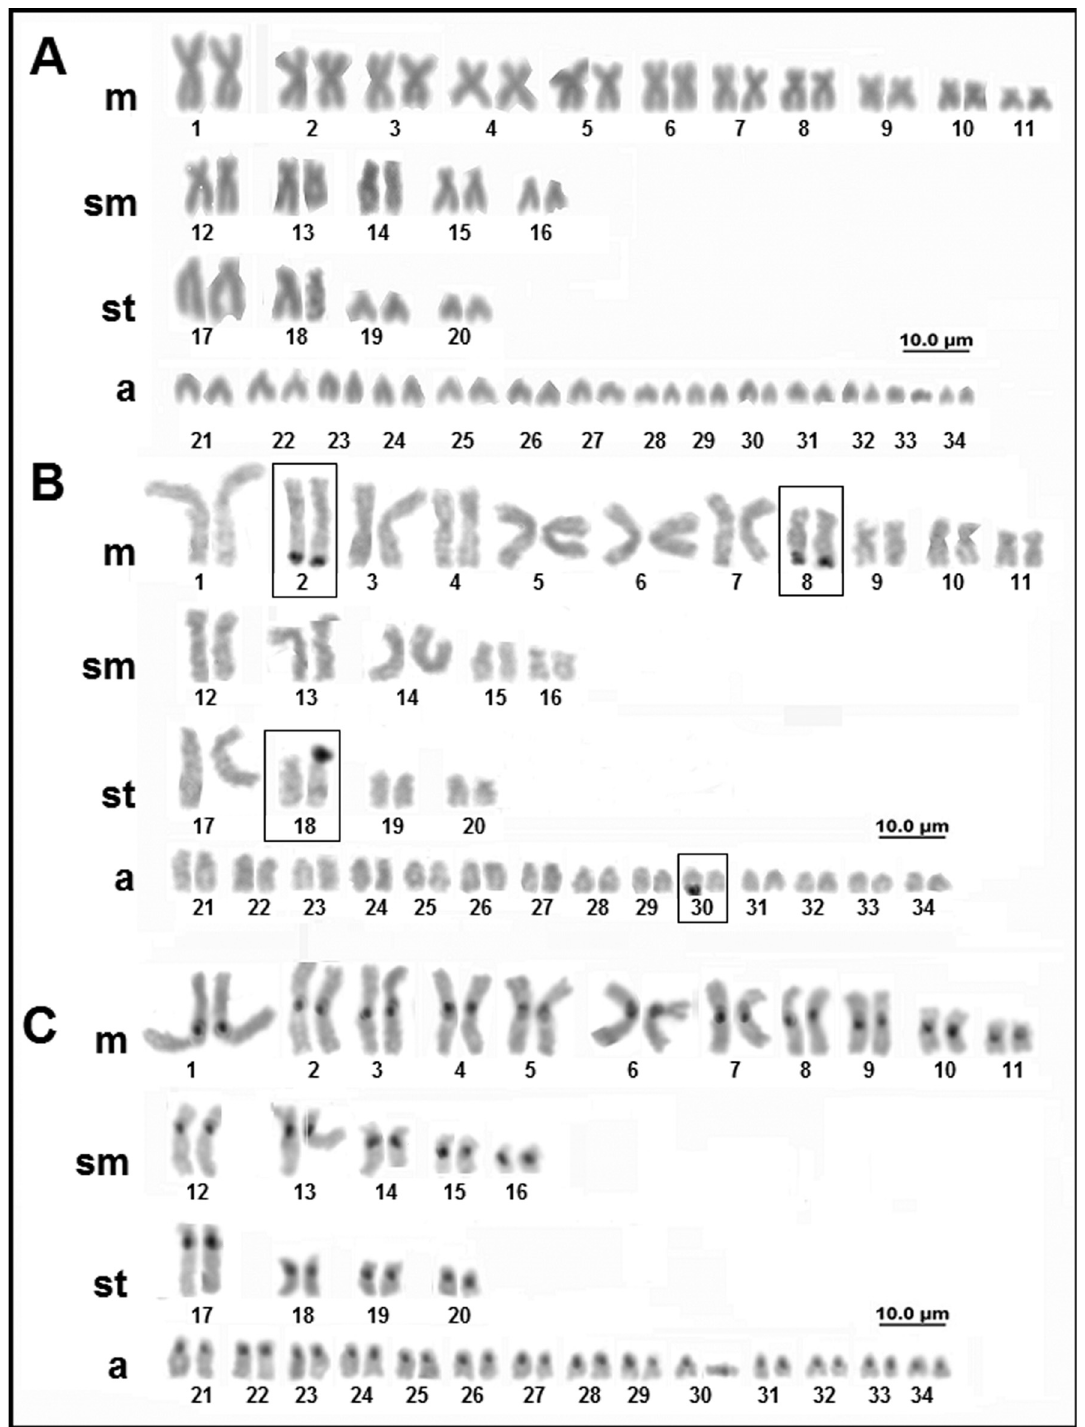
Figure 9 - Karyotype of Potamotrygon aff. wallacei : (A) conventional Giemsa staining; (B) AgNO 3 ; (C)